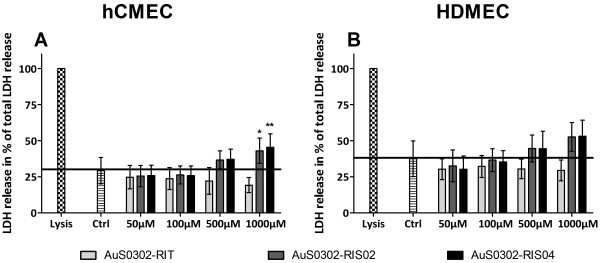
LDH release in hCMEC/D3 and HDMEC after 48 h exposure to AuNPs. The endothelial cells hCMEC/D3 (A) and HDMEC (B) were exposed to different amounts of gold nanoparticles (50 μM – 1000 μM) for 48 hours. Gold-induced cytotoxicity was measured by the LDH release into the supernatant by an enzymatic assay system. As positive control lysed cells were used and set at 100% (lysis). The spontaneous LDH releases of untreated cells are indicated by the black horizontal line. Each result represents the mean ± standard deviation of three independent experiments, each of these was performed at least in triplicates (ONEway ANOVA with Dunnetts t-test: * P < 0.5; ** P < 0.05; *** P < 0.001).